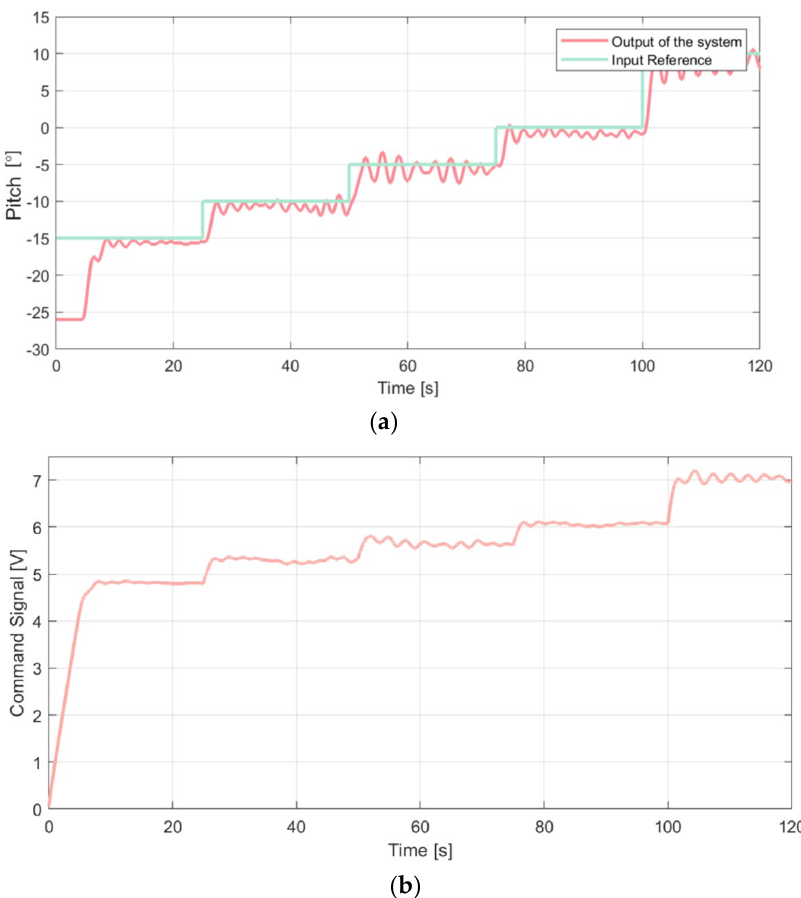
Figure 9. Closed loop experimental results for the VTOL unit using the FOPI controller designed using the proposed toolbox: ( a ) pitch angle, ( b ) voltage signal.